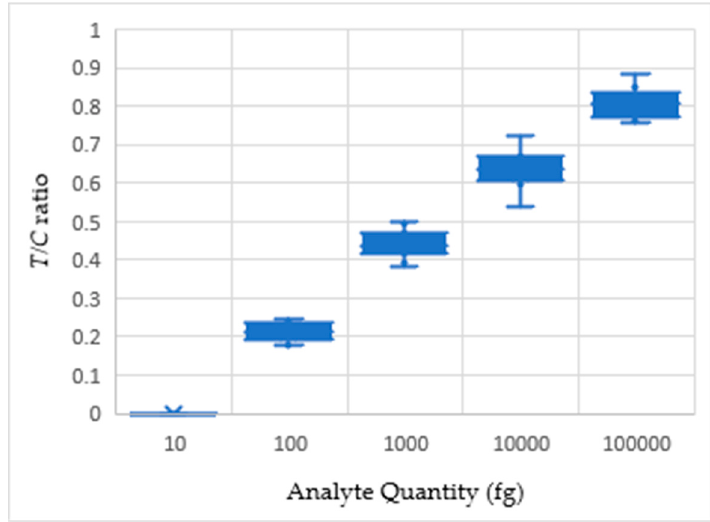
Figure 10. Analyte quantity against T/C ratio plot for three different LFA sets .